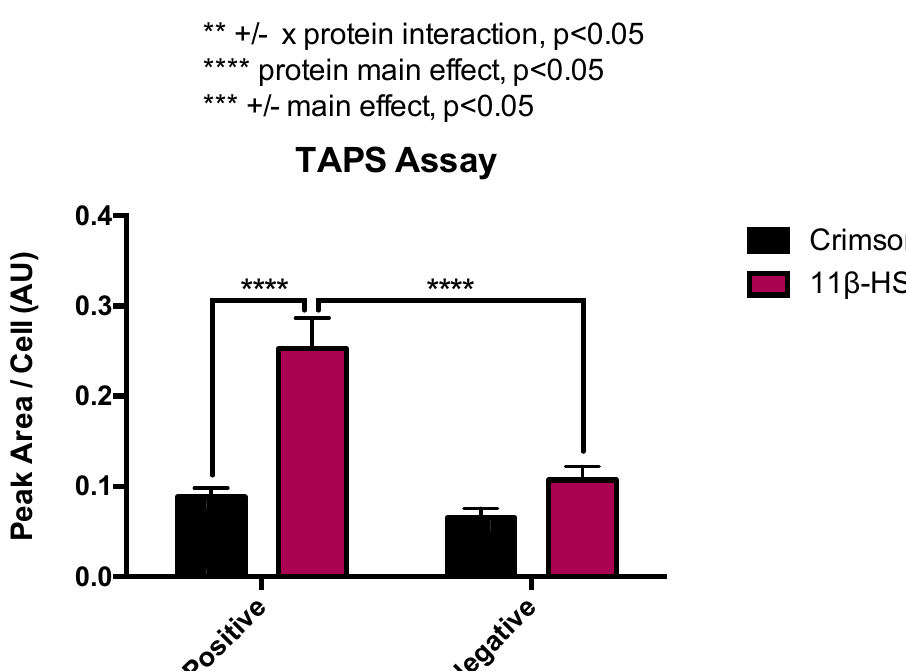
Figure 1. TAPS Assay results showing the peak area per cell. Values are the mean ± standard error of the mean (SEM) ( n = 3), *** p < 0.0001. ** p < 0.01 +/ − x protein interaction; *** p < 0.001 +/ − main effect; **** p < 0.0001 protein main effect. The Y-axis represents the peak area obtained in LC-MS divided by the number of cells evaluated after lysis (see methodology for details).